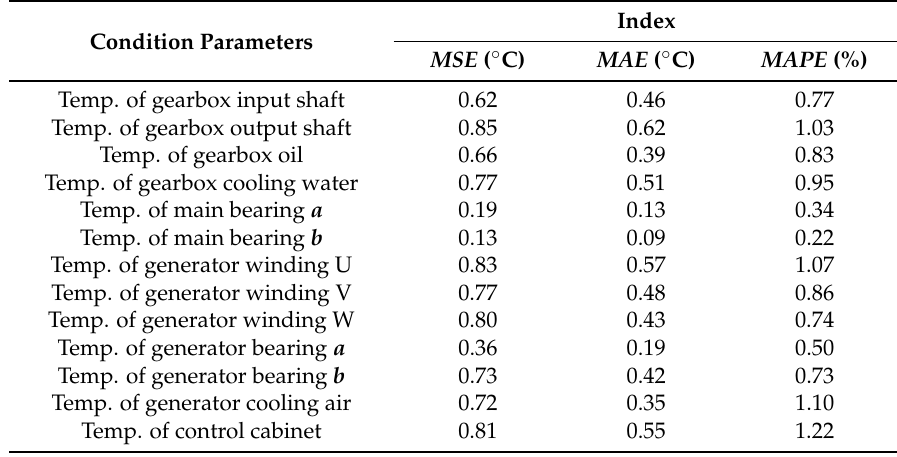
Table 4. Prediction performance of the component temperature parameters (i.e., Type 1